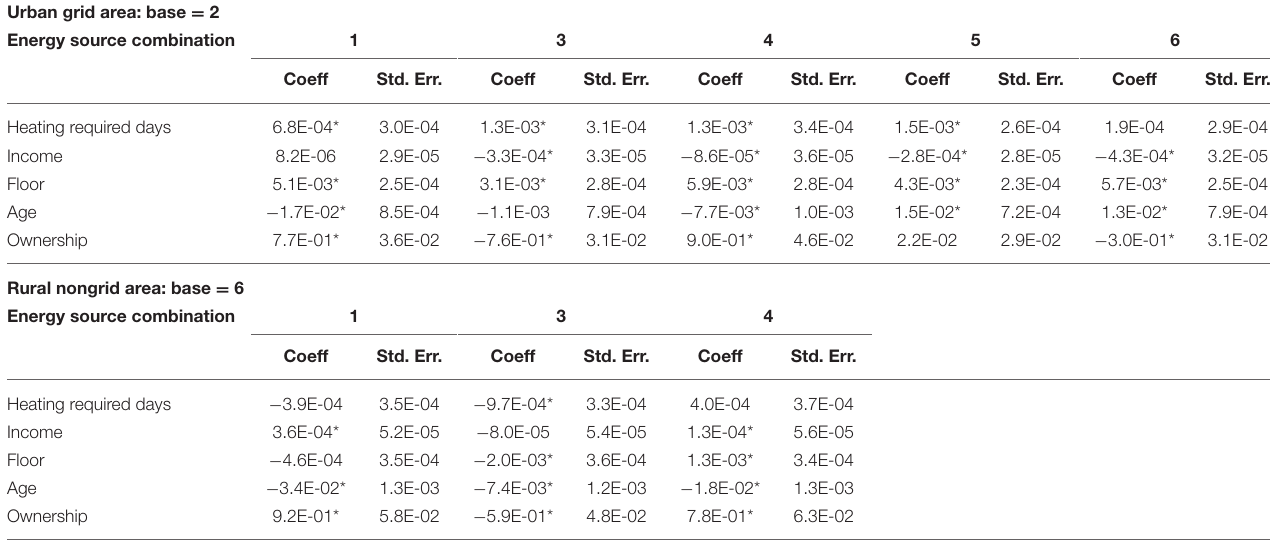
TABLE 3 | Choice of energy source combinations. Urban grid area: base =